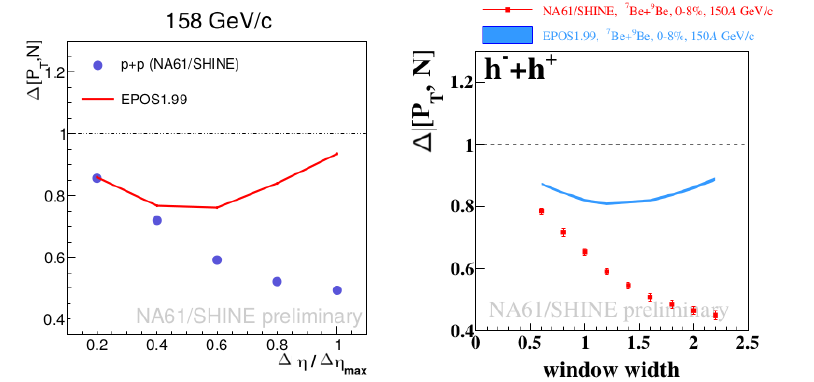
Figure 3. The pseudorapidity dependence of ∆ [ P T , N ] in p + p interactions at 158 A GeV / c (left) and in Be + Be collisions at 150 A GeV / c (right). For details on p + p see Ref. [11] and on Be + Be Ref.